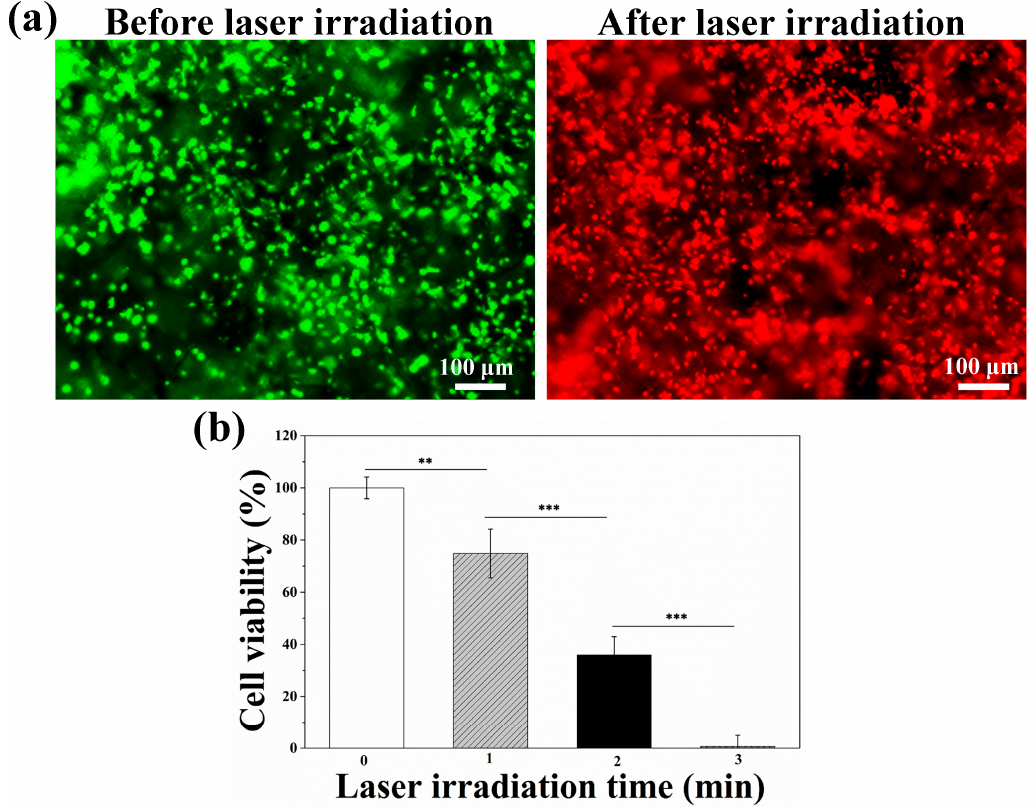
Figure 3. Live/dead staining images of 4T1-Luc cells cultured in the AuNRs–gelatin composite porous scaffolds before and after laser irradiation (805 nm, 1.6 W cm − 2 ) for 3 min ( a ). Green color represents live cells while red color represents dead cells. Viability of 4T1-Luc cells cultured in the AuNRs-gelatin composite porous scaffold after laser irradiation for different time ( b ). The data represent the means ± S.D. (n = 3). Significant difference: ** p < 0.01; *** p < 0.001.